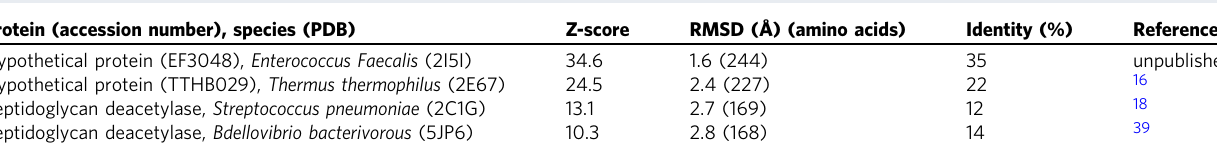
Table 2 Structural similarity search using the DALI server 27